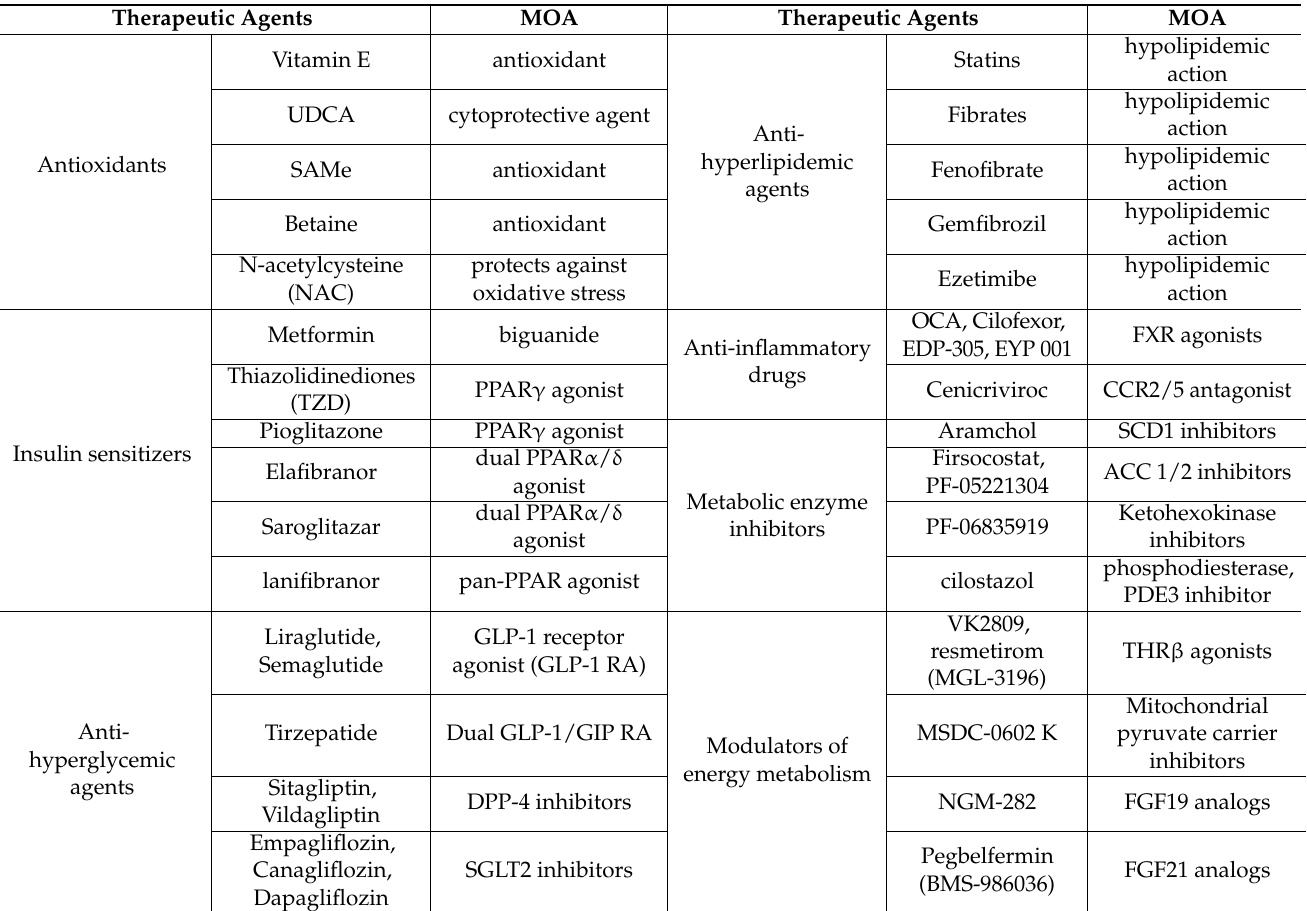
Table 2. Current pharmacotherapeutic strategies in NAFLD